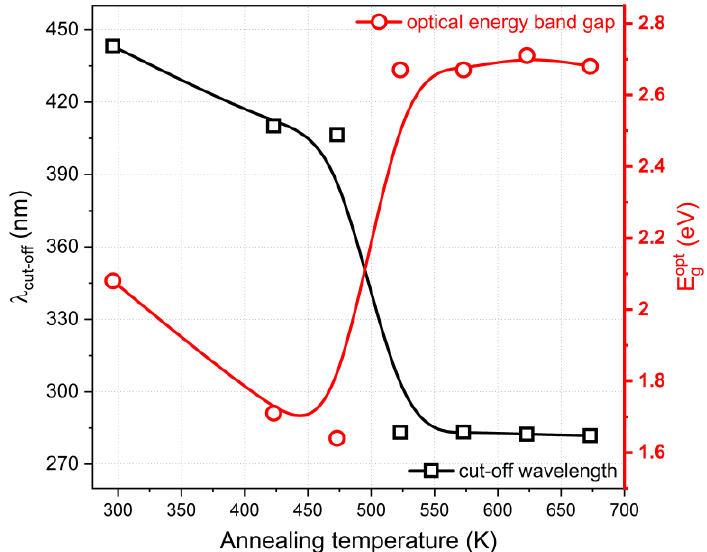
Figure 6. Comparison of the fundamental absorption edge and optical band gap energy of V 2 O 5 thin films annealed at various temperatures.